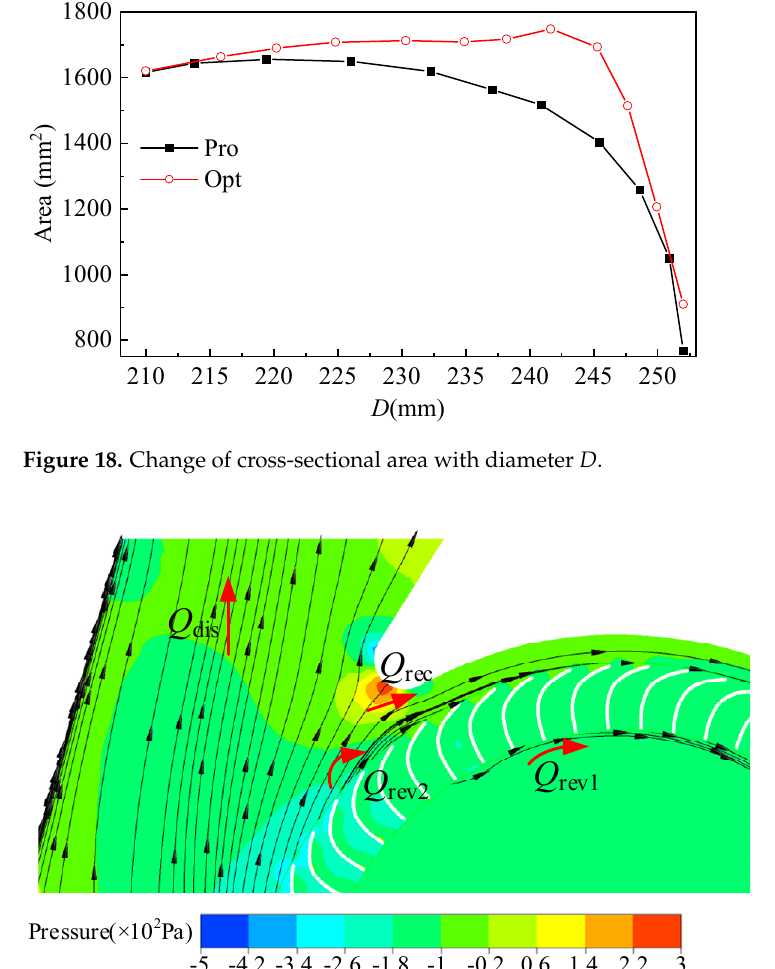
( b ) Figure 17. Comparison of velocity distribution in the middle section: ( a ) the radial velocity at the exit of the impeller inside and the velocity distribution and streamline diagram outside; ( b ) the partial enlargement of the velocity distribution and streamline diagram.